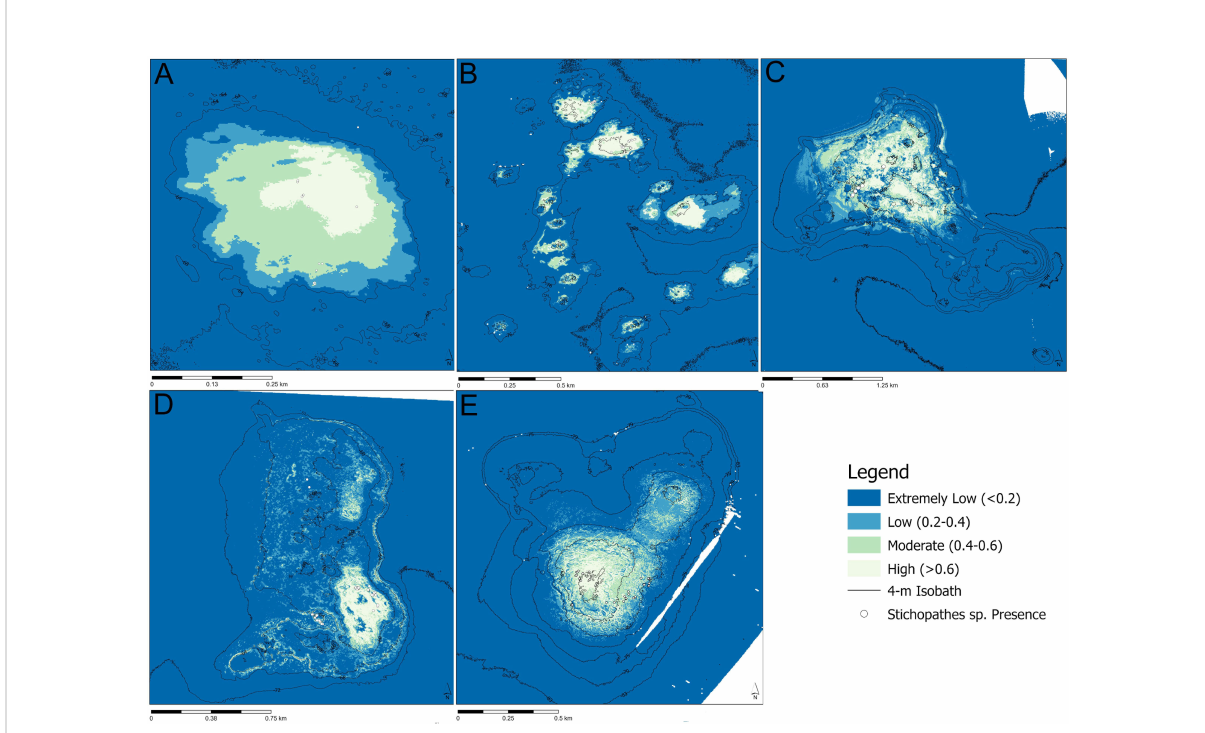
FIGURE 4 Predictive model of habitat suitability for Stichopathes spp. at (A) Big Adam Bank, (B) Mysterious Bank, (C) Hospital Bank, (D) North Hospital Bank, and (E) Southern Bank. Areas that are white to pale blue have a higher probability of the presence of Stichopathes spp., whereas areas that are darker blue have a low probability that Stichopathes spp. will be